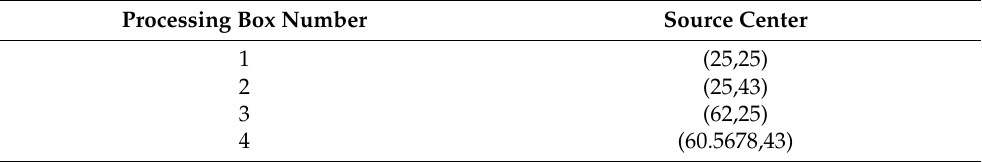
Table 5. The position of the center point corresponding to the processing frame. Processing Box Number